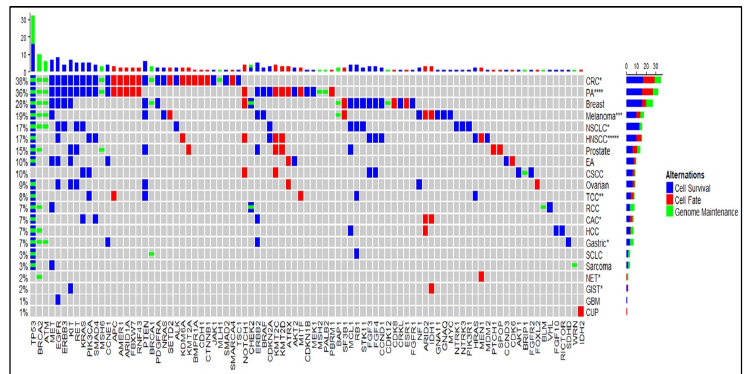
Figure 2. Mutation map showing frequency of gene mutations detected by Caris linked to cancer subtypes and the categories of cell survival, cell fate, and genome maintenance. PD-L1 positive tissue-based IHC found in cancer subtype groups are marked (*) and the number is equivalent to patients.